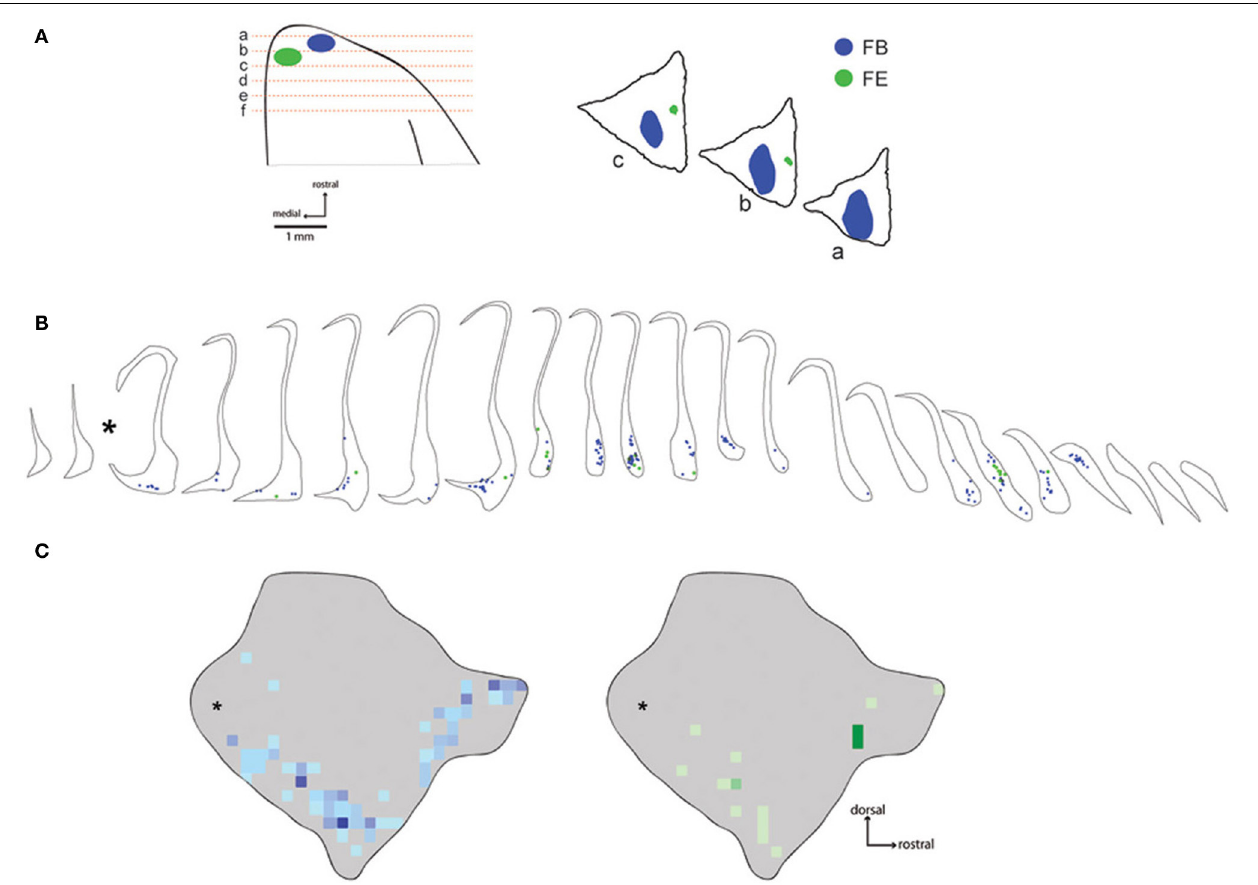
FIGURE 2 | Distribution of labeled neurons following injections in area 10. The placements of fast blue and fluoroemerald injections into the frontal pole are shown in (A) . Coronal section locations are shown schematically on the left, while the positions of the main tracer deposits are shown in the digitized tracings on the right. Note that the fluid volume of the fluoro emerald (FE) injection in this case (FR02) was quite large (1 µ l, Table 1 ), but the largest fraction of the deposit was located in the histologically stained